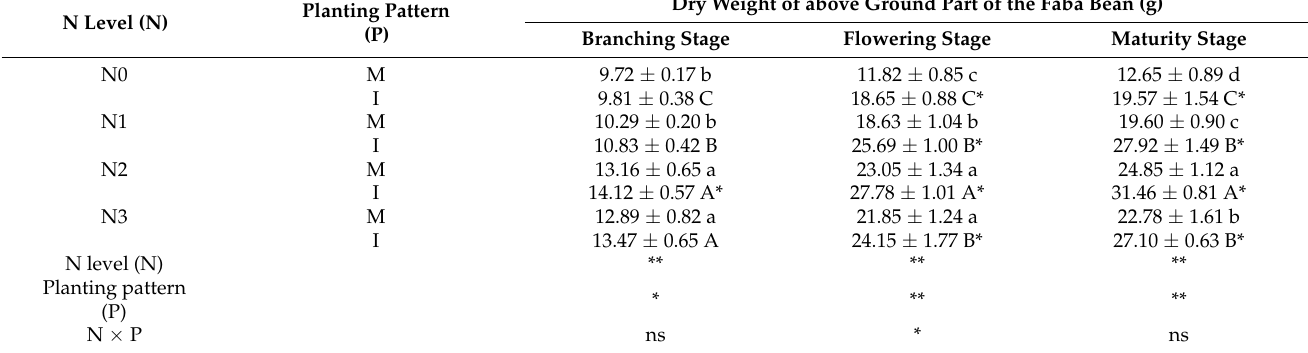
Table 6. Effects of nitrogen application and intercropping on the dry weight of the above ground part of the faba